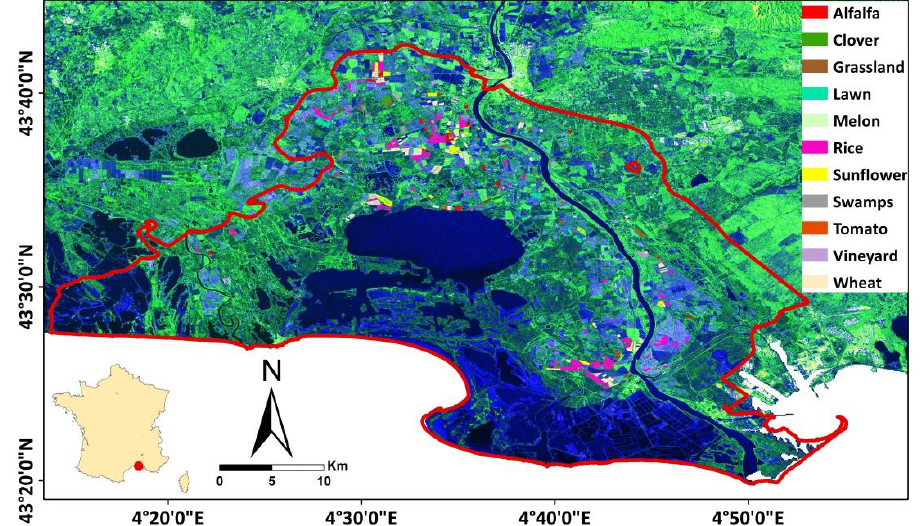
Figure 1. Location of the study site, Camargue, France. The red border represents the study area and the colored polygons represent the reference parcels. The background is a SAR) composite of three bands (Red: VV, Green: VH, and Blue: VV / VH).